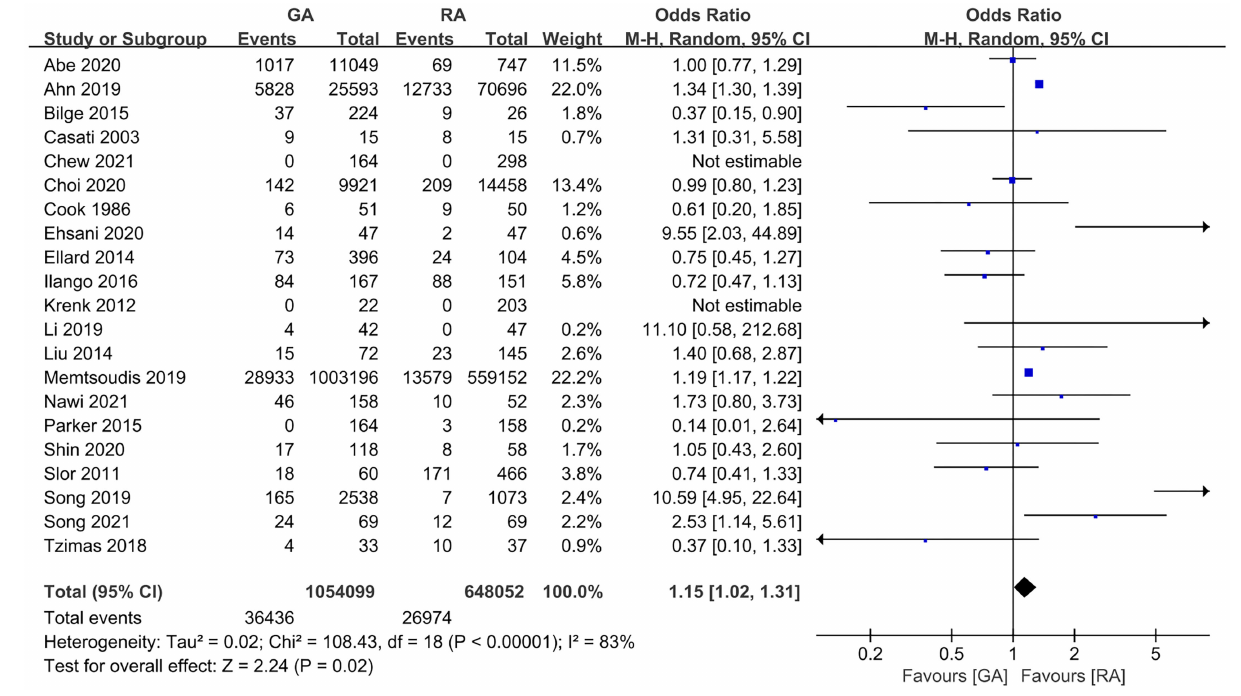
( Figure 7 ), age gap between 60 and 70 years (OR = 1.20, 95% CI: [1.07, 1.35], p for effect = 0.002) ( Figure 8 ), and neuraxial anesthesia (OR = 1.15, 95% CI: [1.01, 1.31], p for effect = 0.03) ( Figure 9 ). However, we did not obtain statistical difference in the subgroups in prospective studies (OR = 0.91, 95% CI: [0.55, 1.49], p for effect = 0.70) ( Figure 6 ), male percentage ≥ 50%